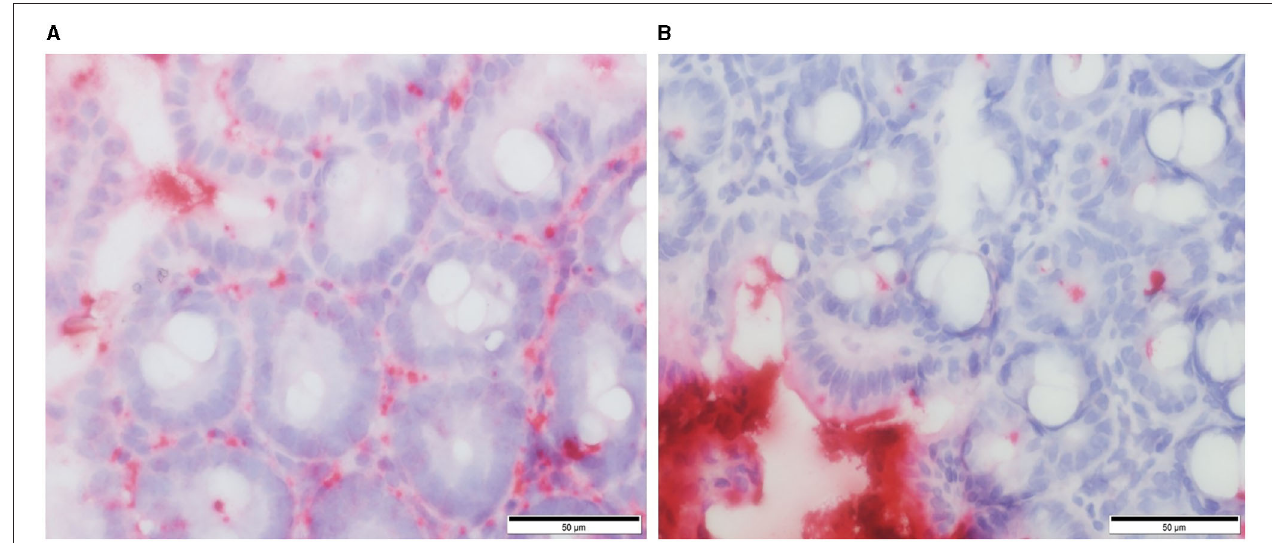
FIGURE 2 | RNA in situ hybridization for total bacteria (EUB probe) in murine cecal tissue specimens. Red staining indicates the presence of bacteria and/or their products within the cecal lamina propria of ASF colonized mice (A) and conventional mice (B) . From: Parvinroo et al. (39) with permission.